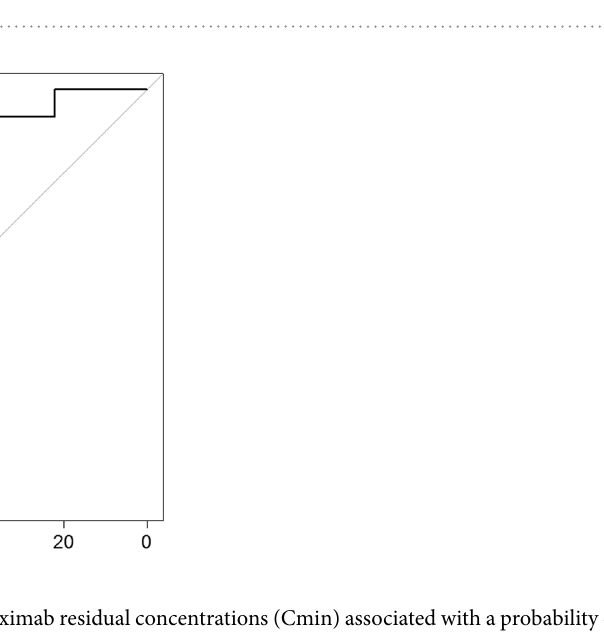
Figure 5. Boxplots comparing cetuximab exposure levels in patients depending on clinical outcome (i.e., Progressive Disease VS. Clinical Benefit). Figure 4-A shows residual concentrations and Fig. 4-B represents maximal concentrations.